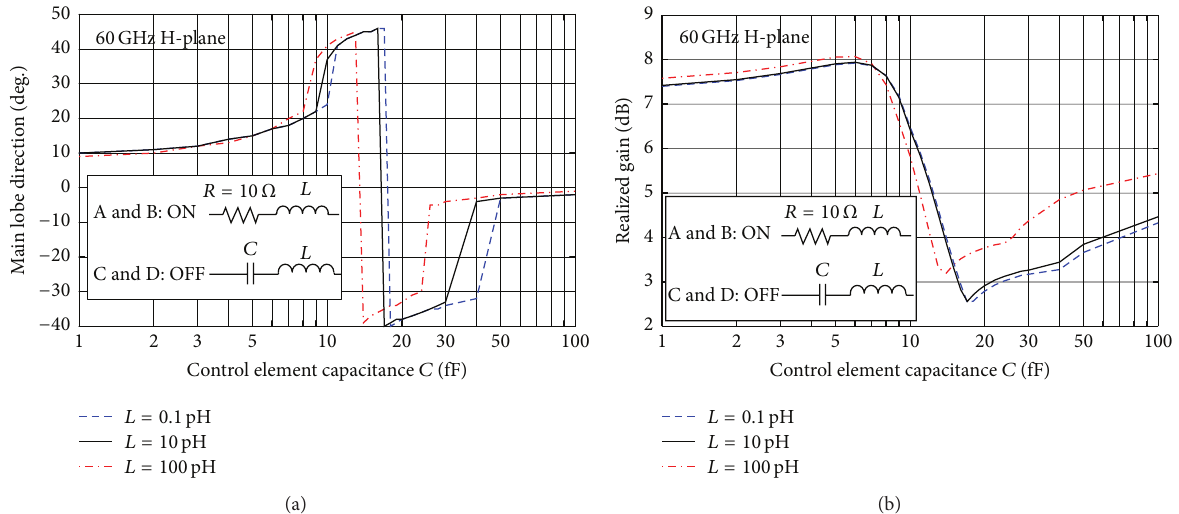
Figure 12: H-plane radiation pattern main beam direction (a) and realized gain (b) at 60 GHz for the reconfigurable antenna with A and B control elements in “ON” state, together with C and D control elements in “OFF” state.